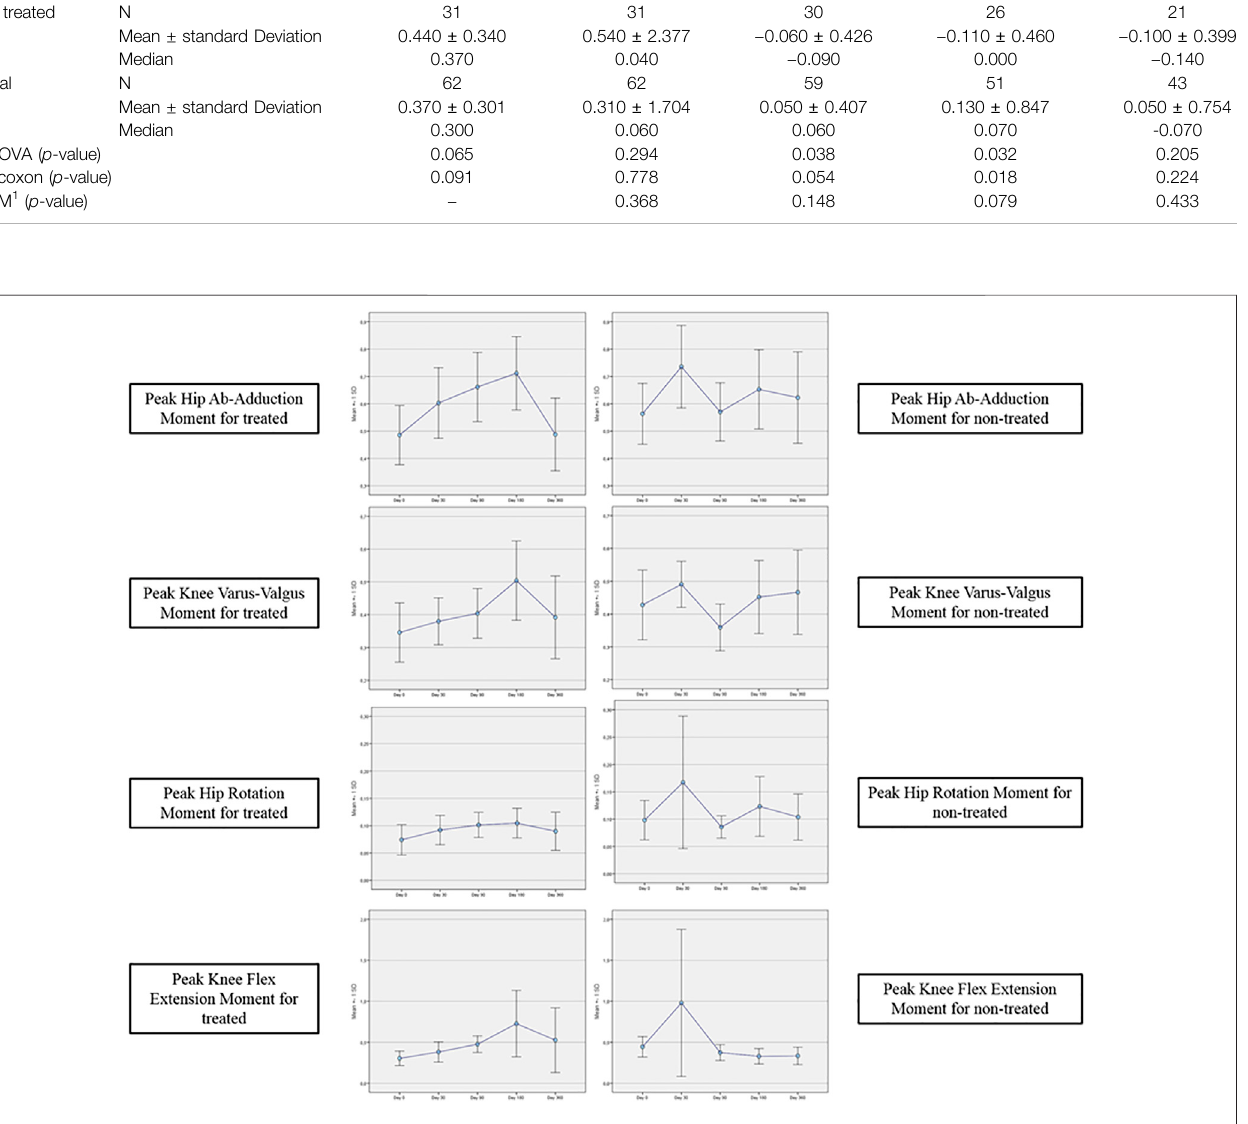
FIGURE 3 | GAIT parameters grouped by treatment (full